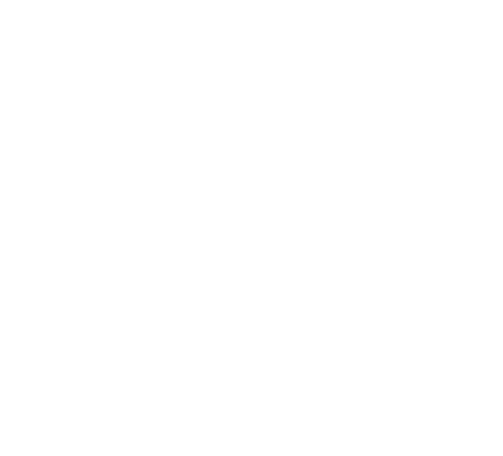
Table 2. Different micro-chamfering widths and depths